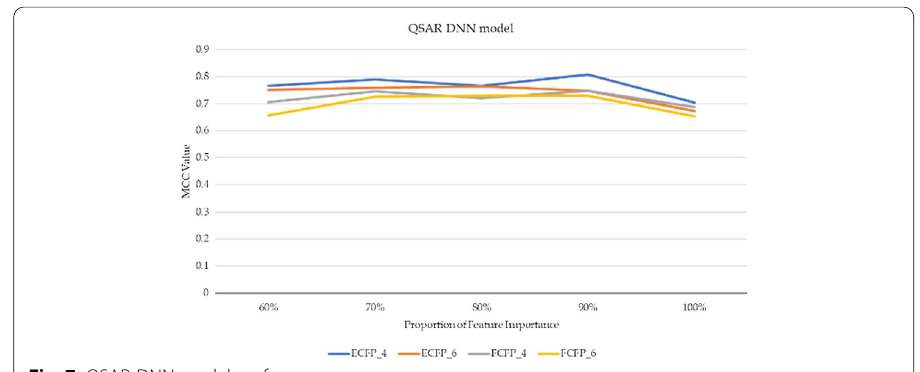
Fig. 7 QSAR-DNN model